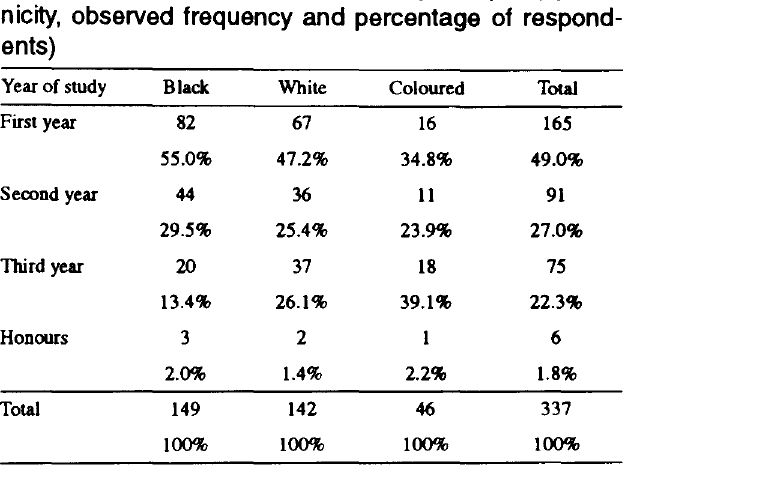
Table 3 Degree major profile of study sample (by eth nicity, observed frequency and percentage of